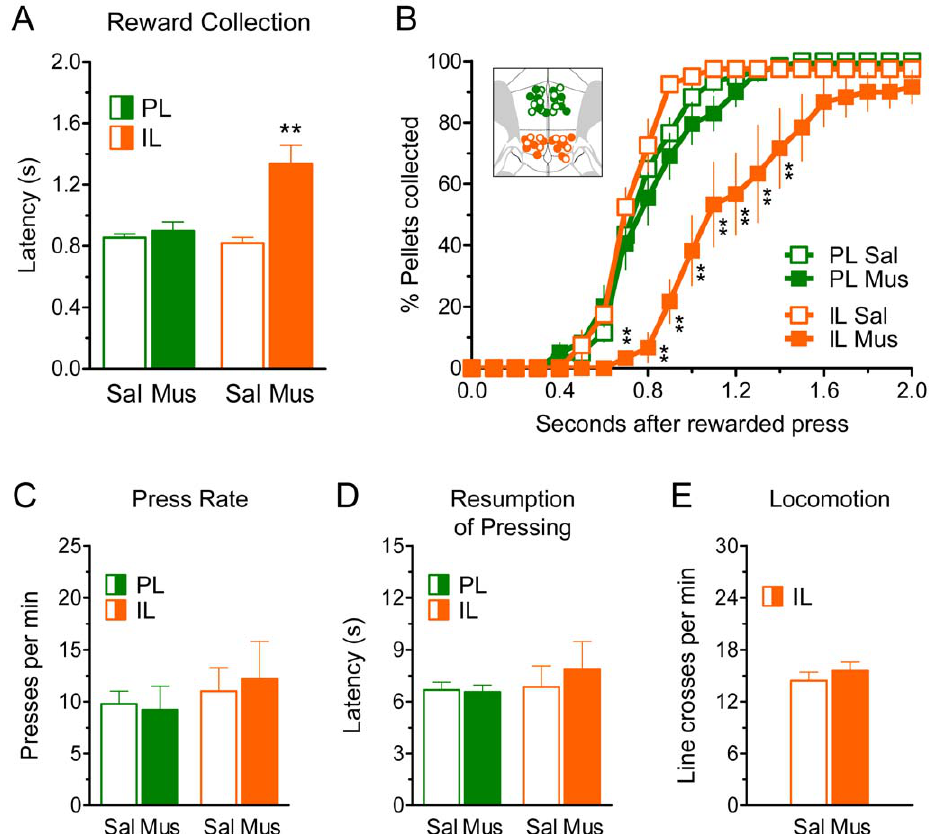
Figure 4. Inactivation of IL, but not PL, altered the time course of reward collection. Either the GABA A agonist muscimol ( Mus ) or saline vehicle ( Sal ) was bilaterally infused into IL or PL 30 min prior to testing animals on VI-60. A–B, Inactivation of IL, but not PL, significantly delayed the collection of earned pellets (** p , 0.01, compared to all other groups). C–E, Other behavioral measures were unaffected by IL or PL inactivation, including the rate of lever pressing ( C ), latency for the resumption of lever pressing after collecting the earned pellets ( D ), or general locomotion in an open-field test ( E ). [Inset in B shows the location of injector tips. PL-Sal: n =6, PL-Mus: n =6, IL-Sal: n =4, IL-Mus: n =6].